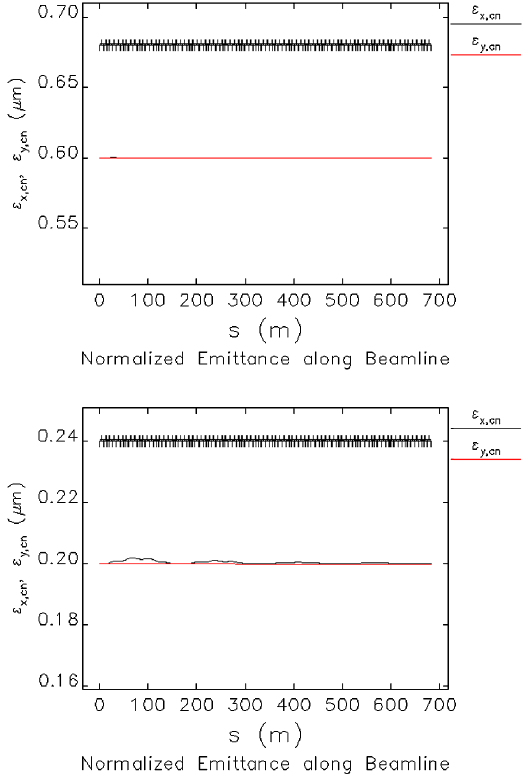
FIG. 2. The evolution of e-beam emittance in the eRHIC arcs for both soft (top) and hard (bottom) x-ray setup. A bunch charge of 0.2 nC is used to minimized the growth of emittance caused by the CSR